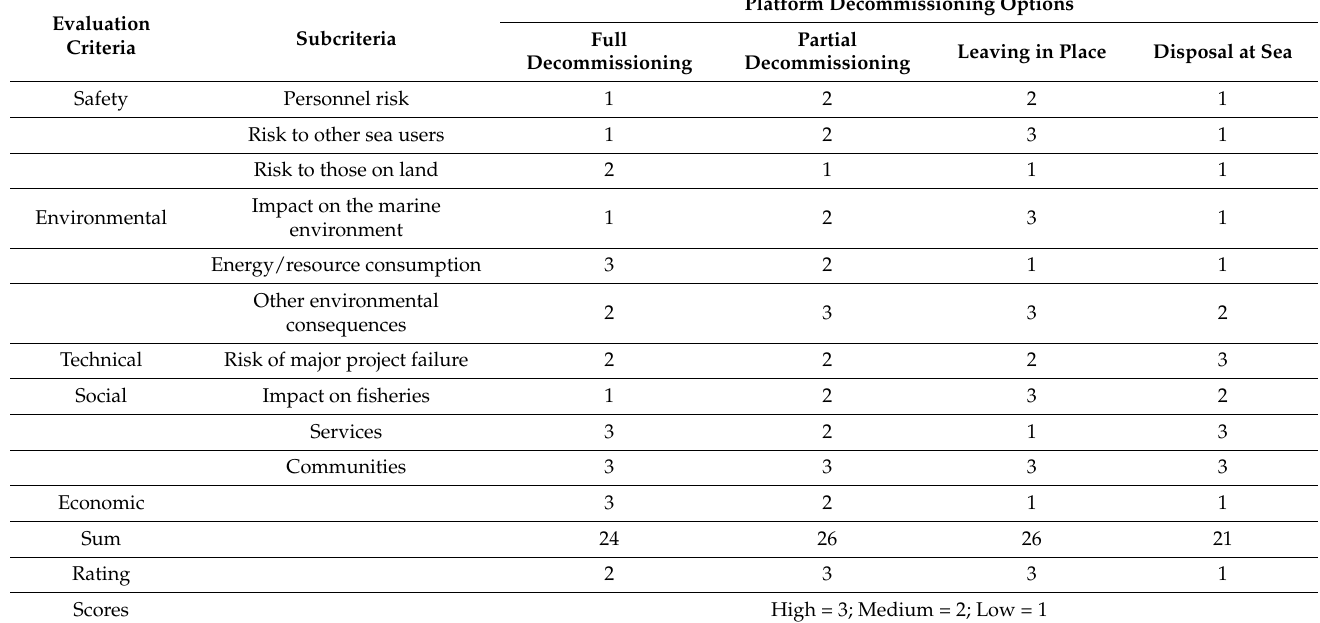
Table 2. Scoring matrix